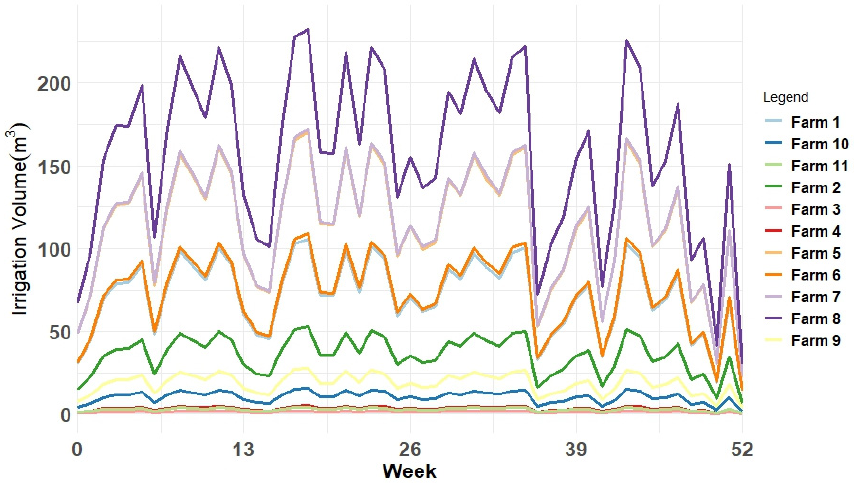
Figure 13. Monthly rainfall (m 3 ) at each urban farm for a one-year period.